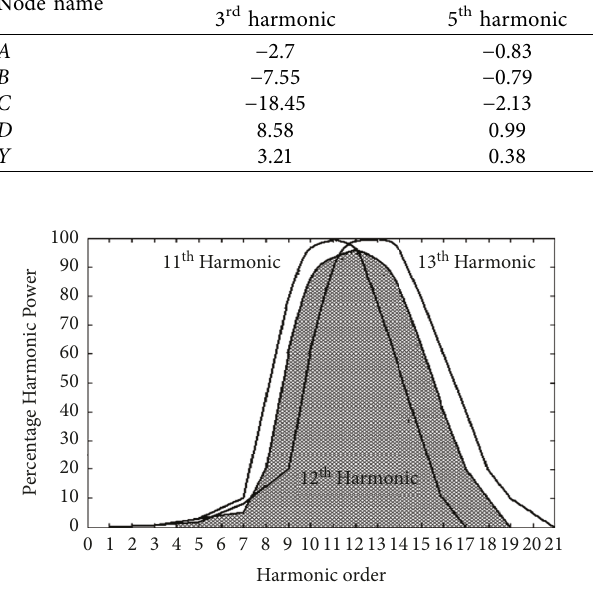
Figure 3: Representation of the 11th, 12th, and 13th harmonics pseudo-frequency vs. captured harmonic